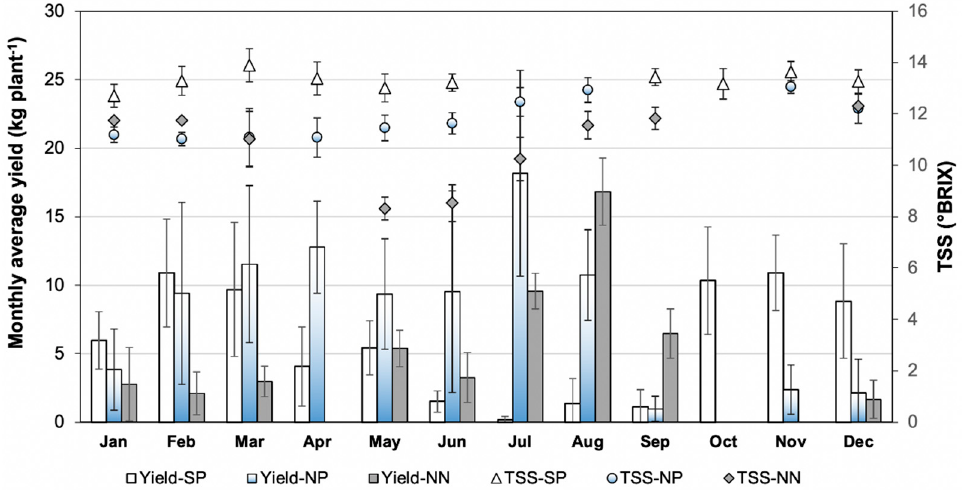
(cid:35) same letter are not significantly different according to the LSD test, at a significance level of 0.05.